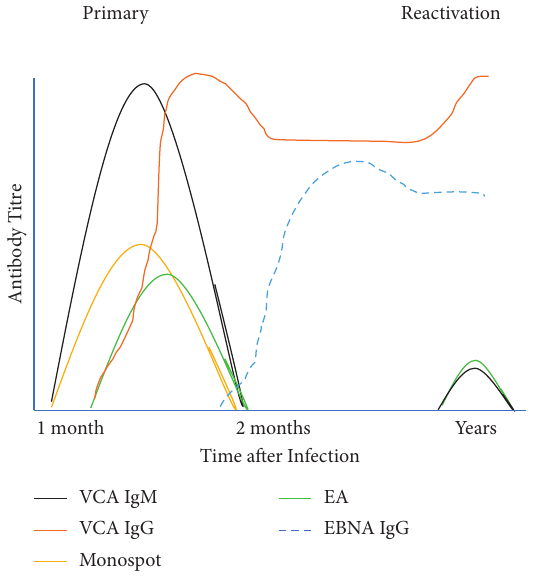
Figure 1: Typical antibody profiles in primary and reactivated EBV